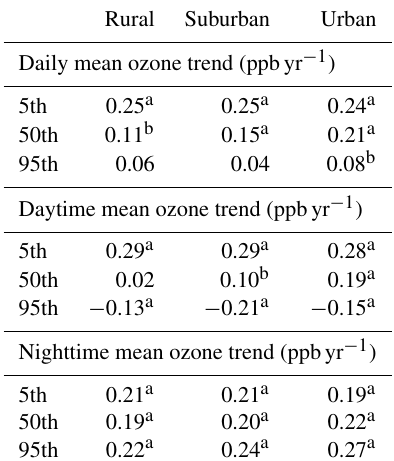
Table 3. Observed trends for the 5th, 50th, and 95th percentiles of ozone over the rural, suburban, and urban areas during